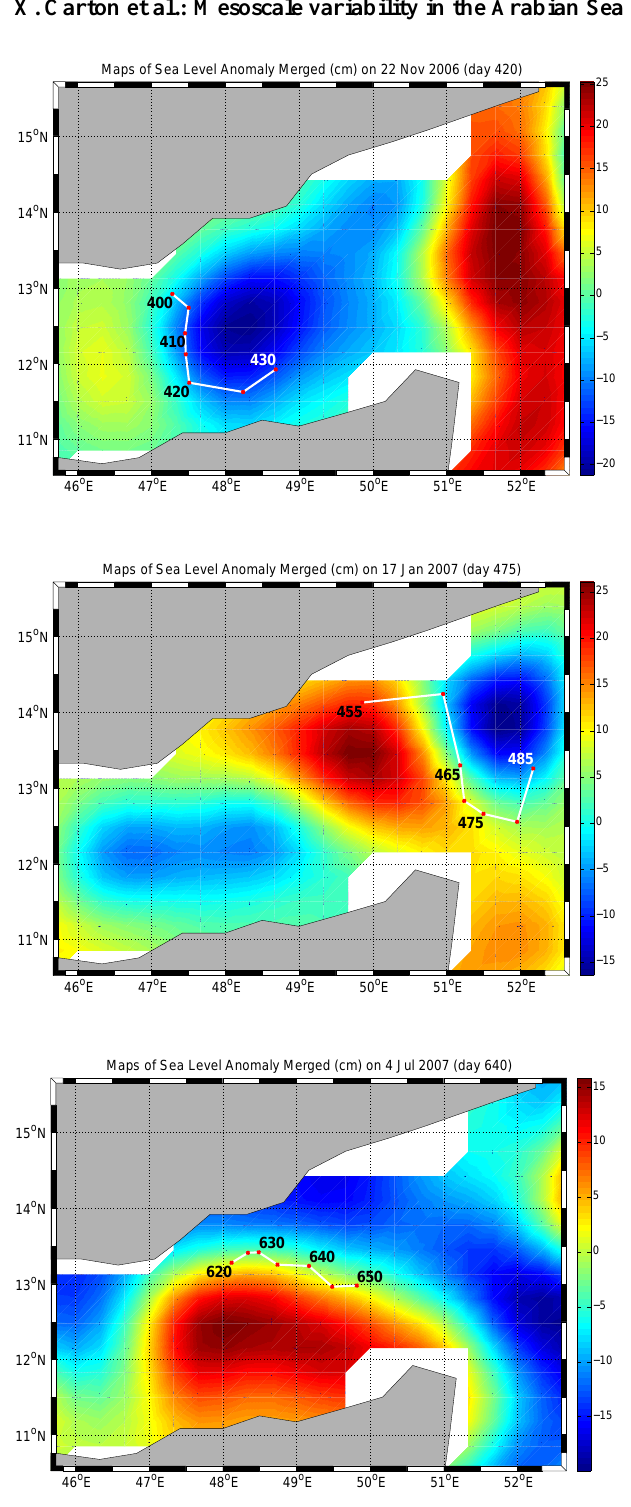
Fig. 11. From top to bottom, sea-level anomaly (SLA) maps of 22 Figure 11: Sea-level anomaly (SLA) maps of November 22nd, 2006 and January 17th, November 2006, 17 January 2007 and 4 July 2007 (days 420, 475 2007 (days 420 and 475 of the mission - from top to bottom, previous page); SLA map and 640 of the mission). The trajectory of float 2900392 for year of July 4th, 2007 (day 640 of the mission - this page). The trajectory of float 2900392 for year 2 is superimposed. Dots indicate the position of the float every 5 days. Mission 2 is superimposed. Dots indicate the position of the float every 5 days are indicated next to the dots. days. Mission days are indicated next to the